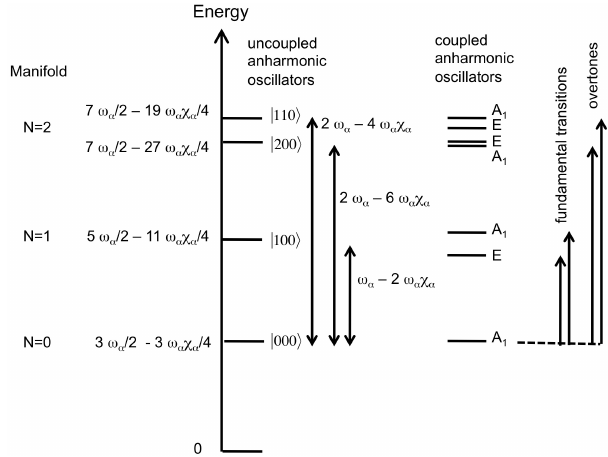
Figure 1. Scheme of the respective contribution of harmonic fre- quencies ( ω α ), anharmonicity parameters ( ω α χ α ) and mode cou- pling in determining the energy of observed fundamental and over- tone transitions for a C 3V symmetry. Note that the figure is not to scale because the harmonic frequencies are significantly larger than the anharmonicity and mode coupling